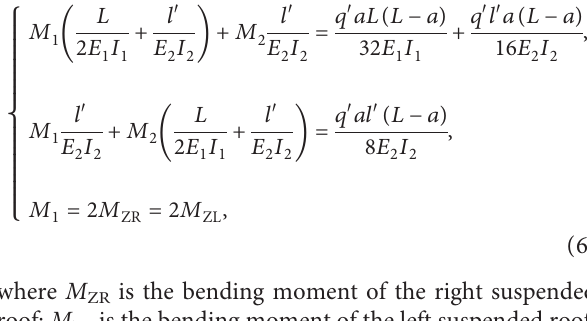
Figure 5: Model simplification bearing only overburden